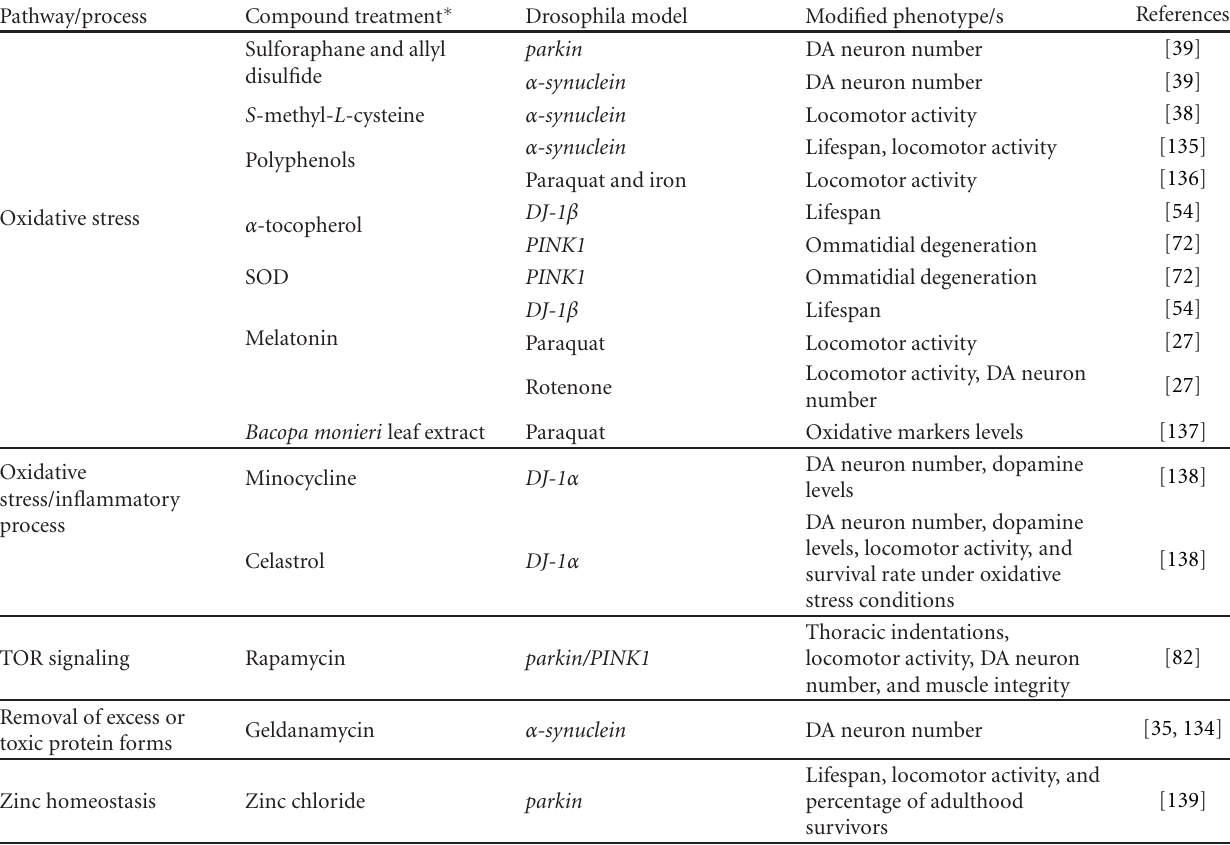
Table 2: Potentially therapeutic compounds able to modify di ff erent phenotypes in the Drosophila PD